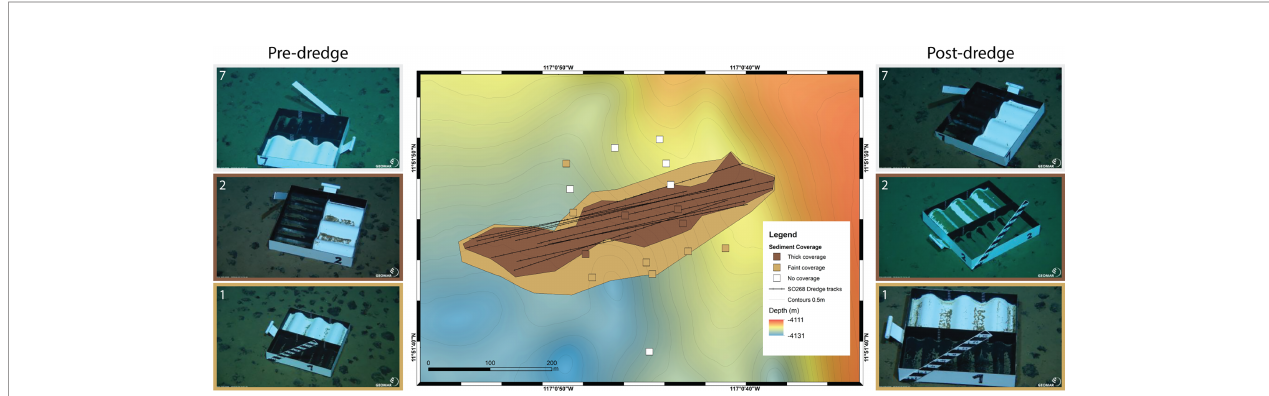
FIGURE 11 | Map showing the visually assessed sediment coverage of the nodules, distinguishing “ no coverage ” (white/no colour), “ faint coverage ” (light brown) and “ thick coverage ” (dark brown) (Schoening et al., submitted). The isobath contour interval is 0.5 m. Pre- and post-dredge photos (left and right) of three SLIC boxes illustrate different amounts of sediment accumulation: no coverage (box 7, top), thick coverage (box 2, middle), and faint coverage (box 1, bottom). From these images it is clear that sediment has resettled in the troughs of the SLIC boxes, but especially in case of SLIC box 2, also forms a drape on the crests. These SLIC boxes, designed by GEOMAR, consist of two 25x50 cm sections of corrugated iron painted white and black, contained in a 50x50x8 cm iron frame. An oblique measuring stick was mounted on one side of each box. (Photo courtesy: GEOMAR, ROV Team Kiel